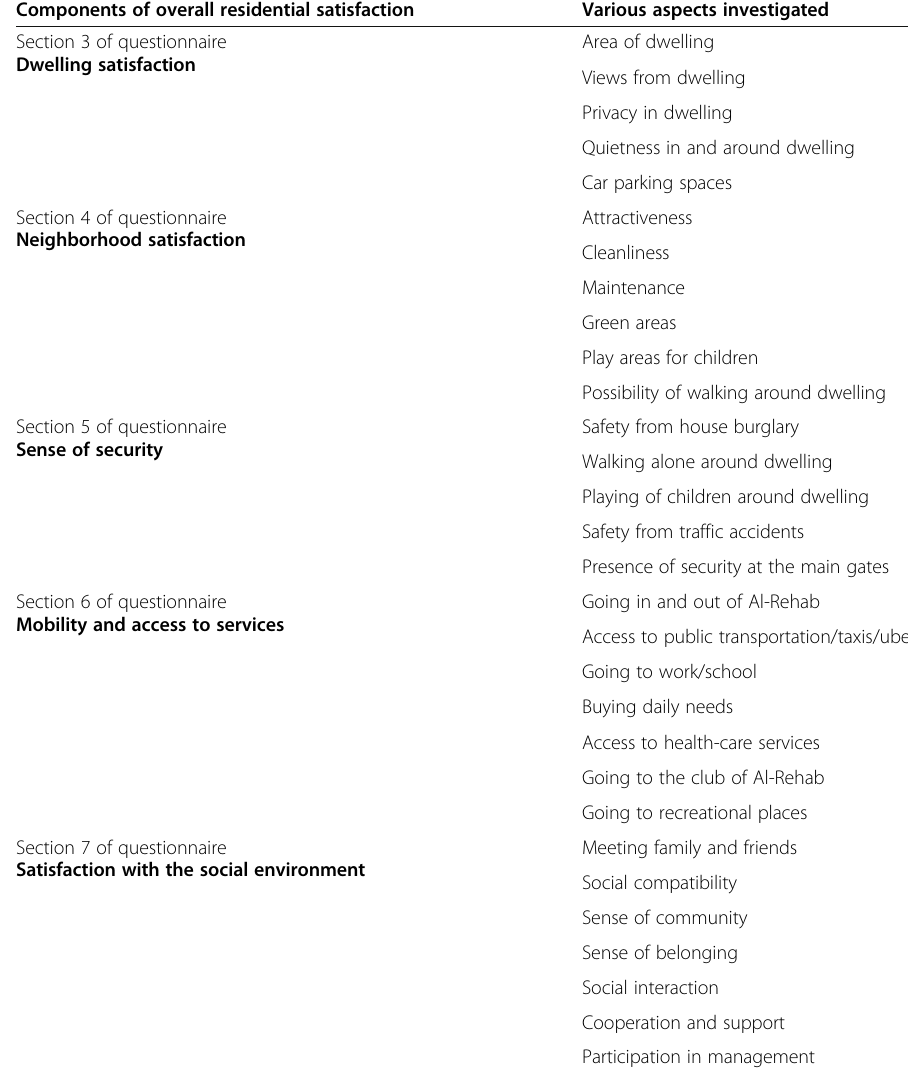
Table 1 Components of overall residential satisfaction and their various aspects